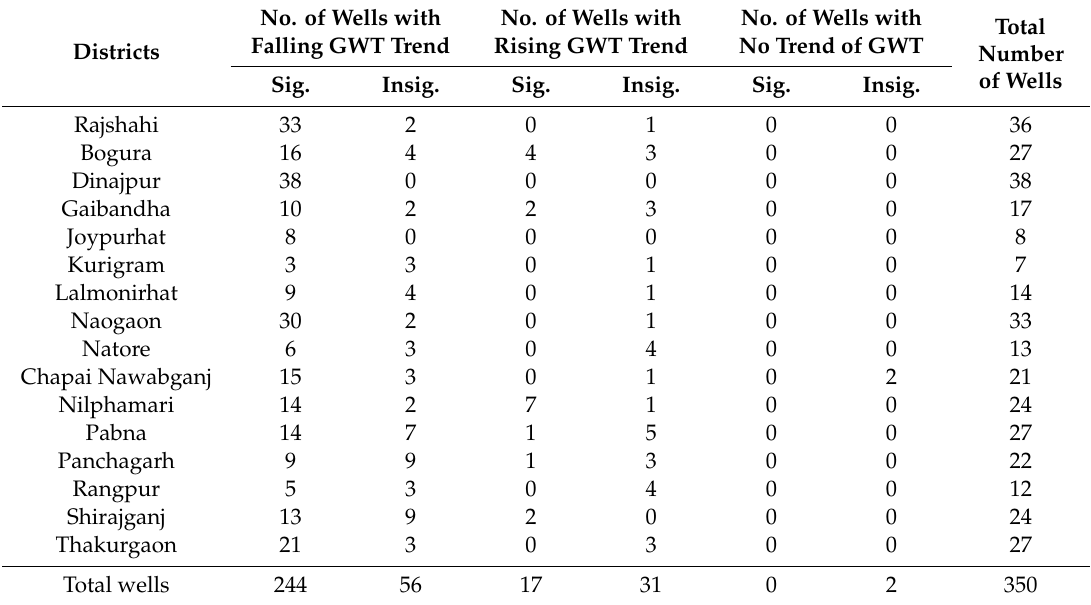
Table 2. Distribution of groundwater table (GWT) monitoring wells based on statistical significance ( p ≤ 0.05) of their annual maximum GWT trends in 16 districts of the North-West hydrological region of Bangladesh.